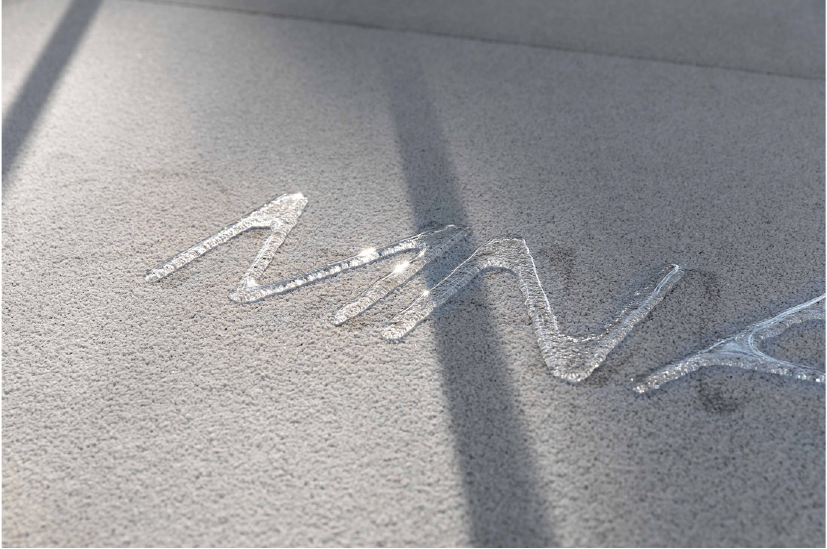
Fig. 20 Doris Salcedo, Palimpsesto 2017, Madrid, Museo Reina Sofía, Palacio de Cristal (detail: precious stones) © White Cube, photographer Patrizia